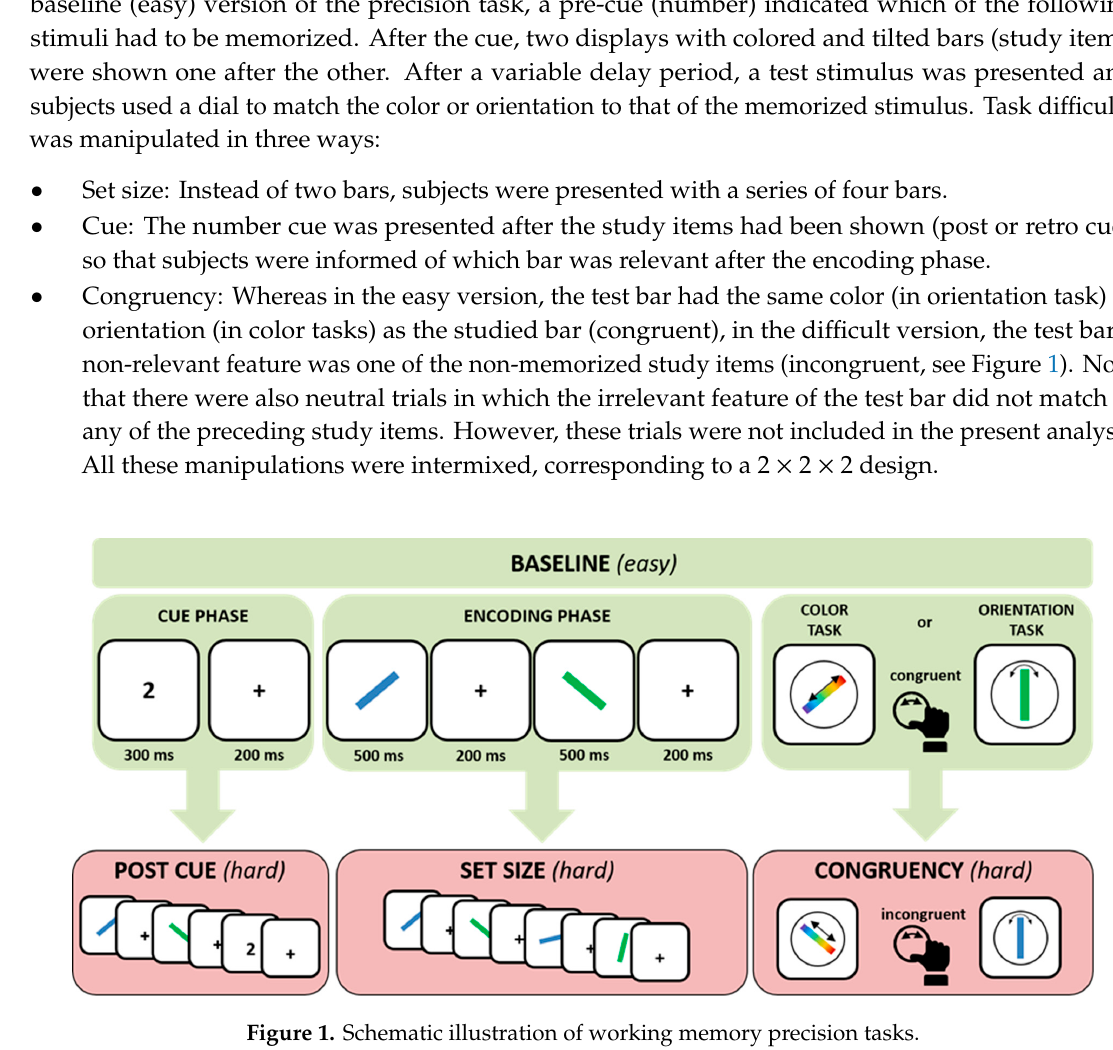
Figure 1. Schematic illustration of working memory precision tasks .